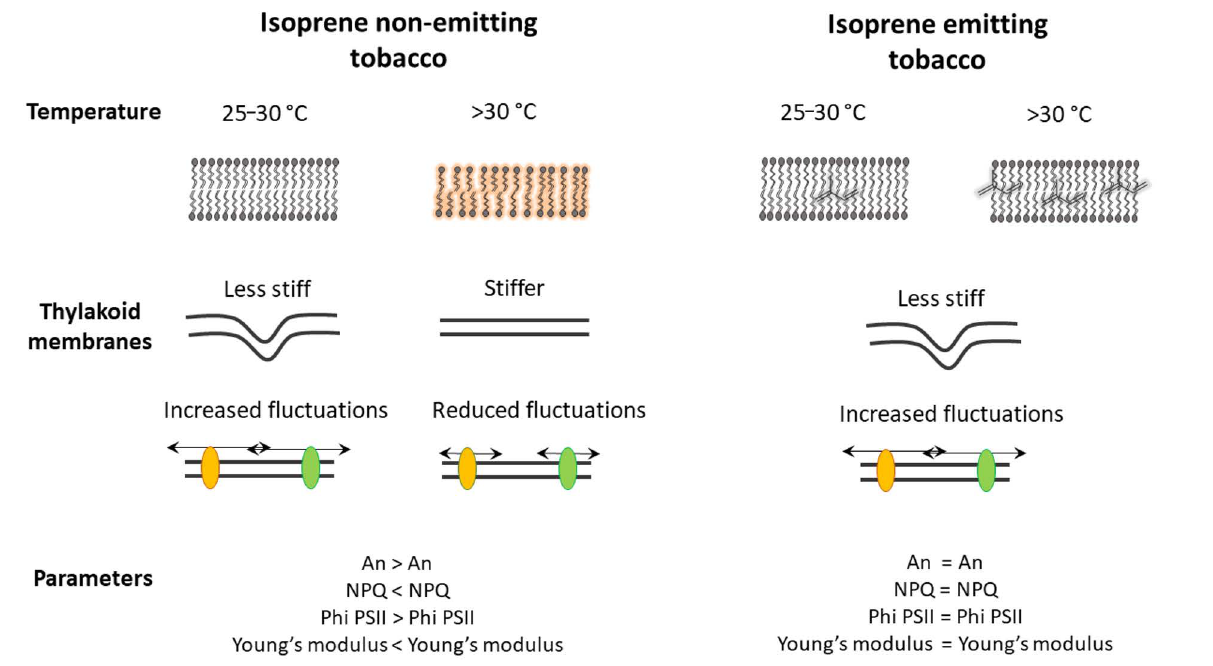
Figure 2. Schematic overview of isoprene mode of action on membrane physiology, according to [47]. At physiological temperatures (25–30 ◦ C), photosynthesis (An), non-photochemical quenching of chlorophyll fluorescence (NPQ), efficiency of Photosystem II (Phi PSII) and thylakoid membrane stiffness (Young’s modulus) are similar in isoprene-emitting and non-emitting leaves. At temperatures higher than 30 ◦ C isoprene-emitters maintain unaltered these parameters, whereas in non-emitters An and PhiPSII were reduced, and NPQ and Young’s modulus increased. These results and further tests of membrane stability are explained by the fact that thylakoidal membranes of isoprene-emitting leaves uphold reduced stiffness even at high temperatures, which maintains the order of membrane lipid chains, and allows increased fluctuations and diffusions between molecules within the membranes, in turn keeping stable